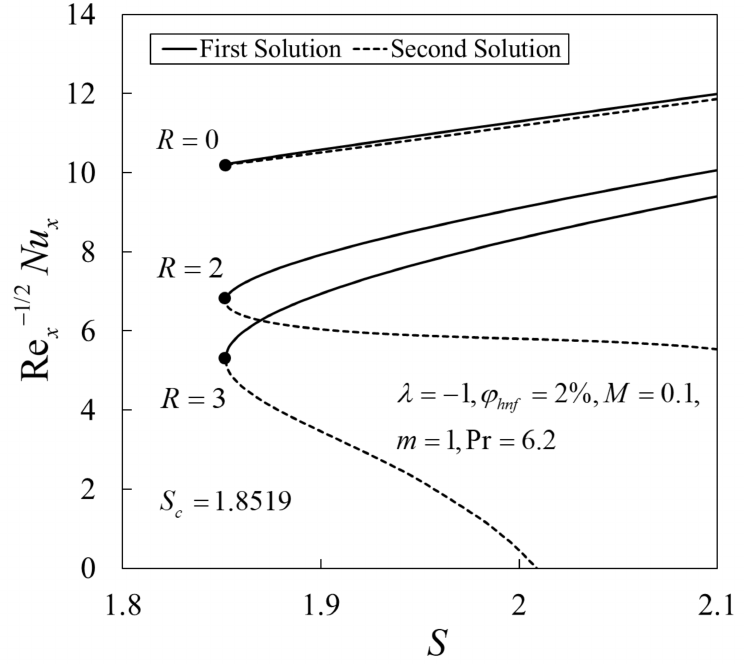
Figure 9. Variations of the local Nusselt number Re − 1/2 x Nu x against suction parameter S for different values of R